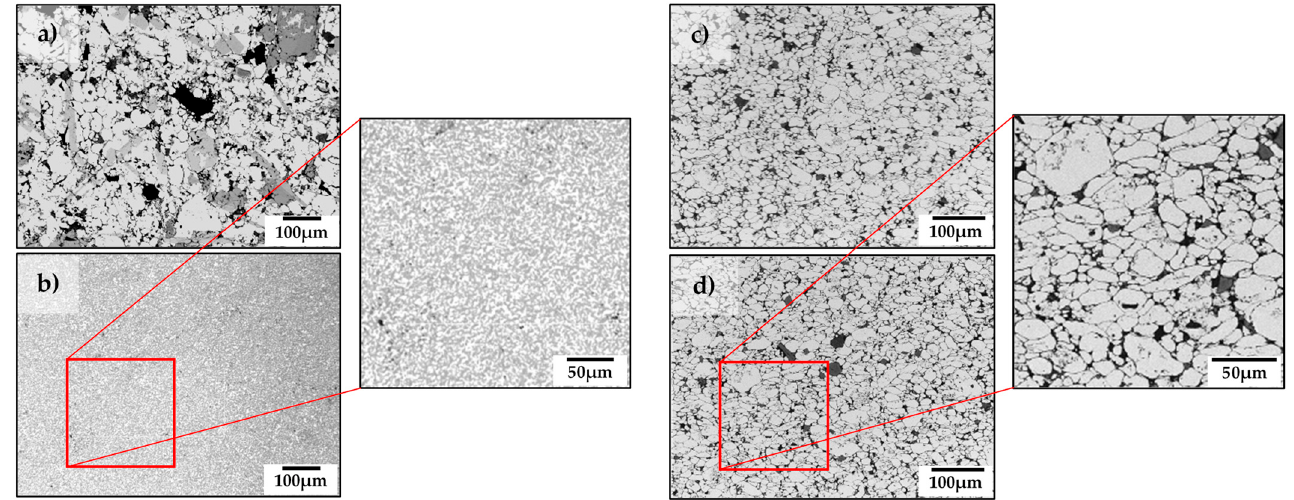
Figure 5. Microstructure comparison of PIT Al-8Ce wt % sample ( a ) before and ( b ) after heat treatment at 400 °C for 8 h., and PIT Al-14Ce wt % ( c ) before and ( d ) after heat treatment at 400 °C for 8 h.